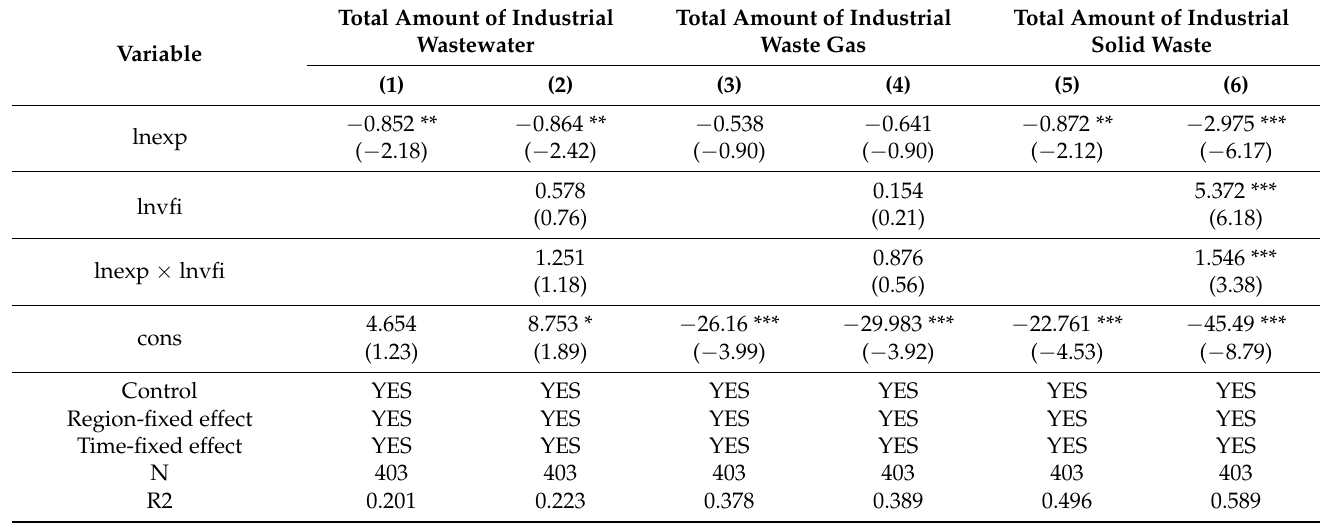
Table 6. Regression results of pollution reduction effect of fiscal expenditure structure (total amount of three types of waste).